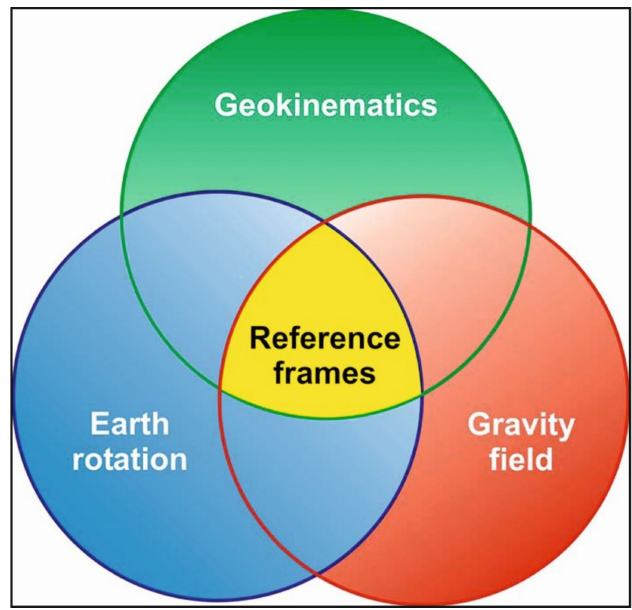
Figure 1. “Three pillars” of geodesy